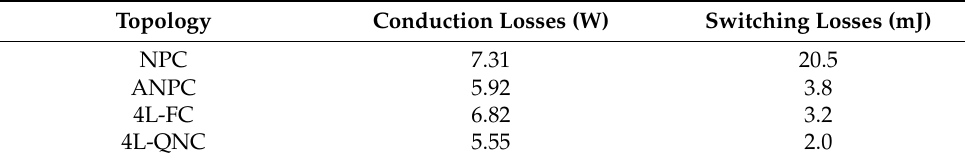
Table 3. Conduction and switching losses (fundamental cell).